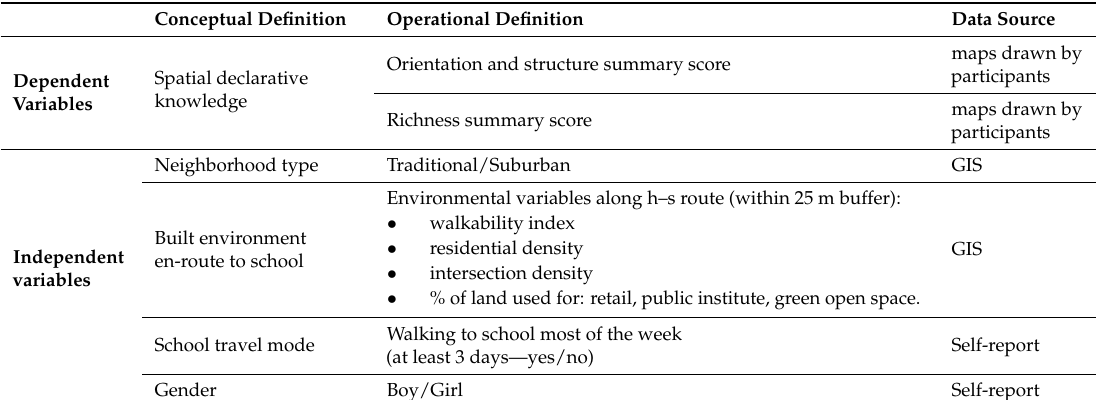
Table 1. List of dependent and independent variables and their